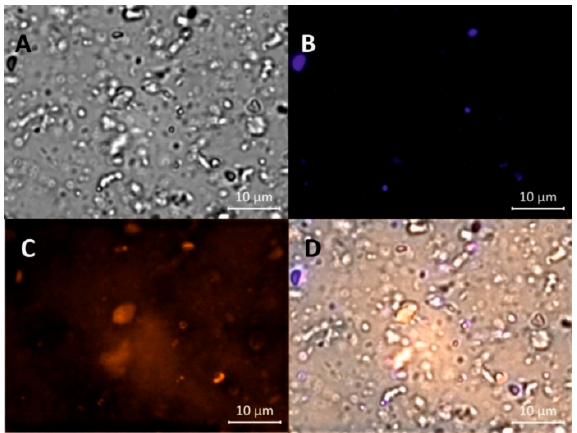
Figure 1. Image of Resv@MDH powder dispersed in glycerol under different excitation sources. ( A ) Bright-field; ( B ) DAPI (4 (cid:48) ,6-diamidino-2-phenylindole) fluorescence filter; ( C ) Rhodamine fluorescence filter; ( D ) merging of the Bright-field, DAPI and Rhodamine